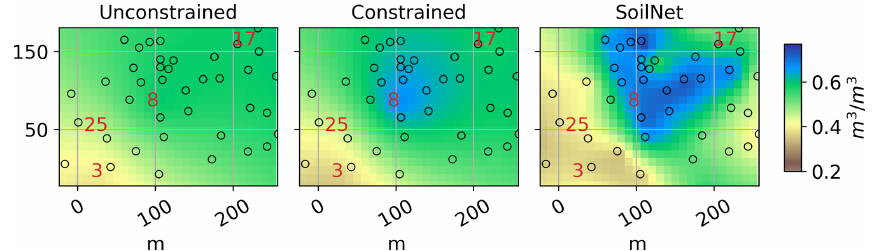
Figure 8. Daily average soil moisture in the SoilNet area on 7 June 2019, as obtained from the unconstrained interpolation (left panel), the constrained interpolation (centre panel), and the interpolated SoilNet measurements (right panel). The spatial window corresponds to the dashed white box in Fig. 6. Black circles: locations of the SoilNet nodes; red numbers: CRNS sensor locations and IDs.